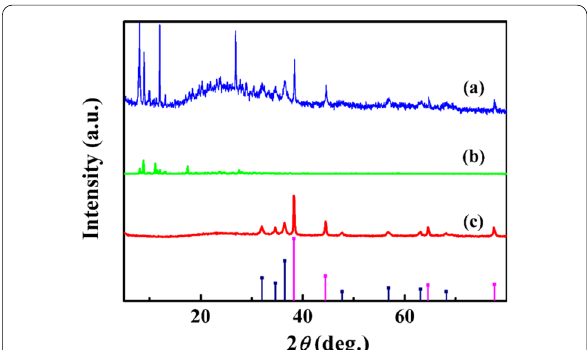
Fig. 2 XRD patterns of a AgZnO/POMs nanocomposites, b POMs, c AgZnO hybrid nanoparticles (the purple and blue column charts are the column diagrams of Ag and ZnO labeled cards, respectively)